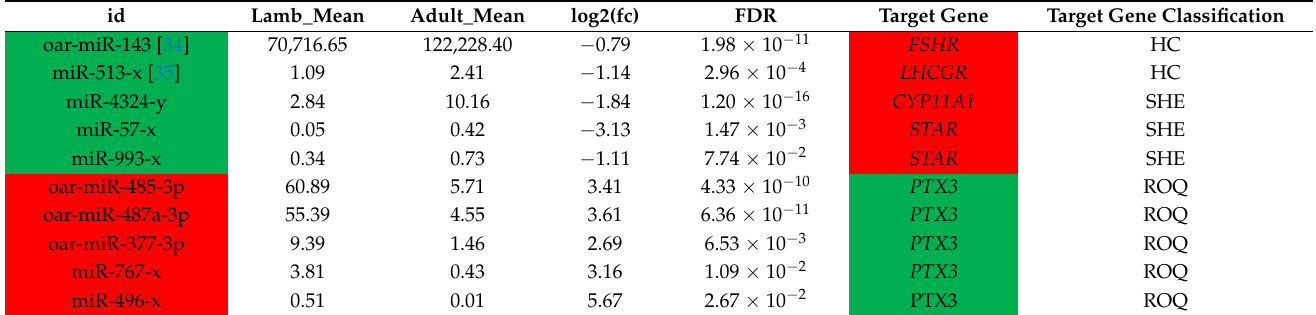
Note: Molecules with a red background represent upregulation in the lamb libraries compared to the adult sheep libraries (FDR < 0.05, log 2 (fc) > 1); molecules with a green background represent downregulation in the lamb libraries (FDR < 0.05, log 2 (fc) < –1). HC—the gene is classified into the hormone receptor gene; SHE—the gene is classified into the steroid hormone secretion gene; ROQ—the gene is classified into genes related to oocyte